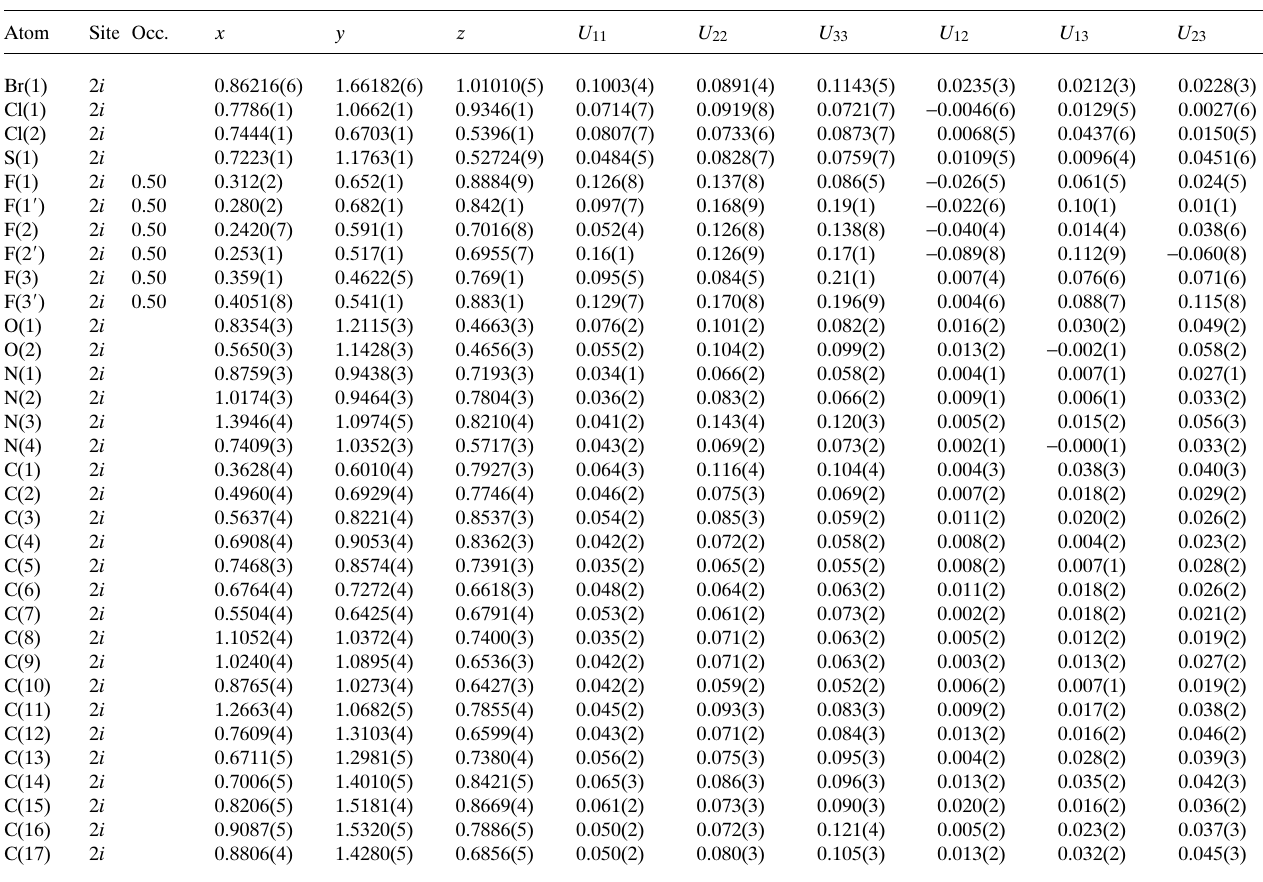
Table 3. Atomic coordinates and displacement parameters (in Å 2 ) .